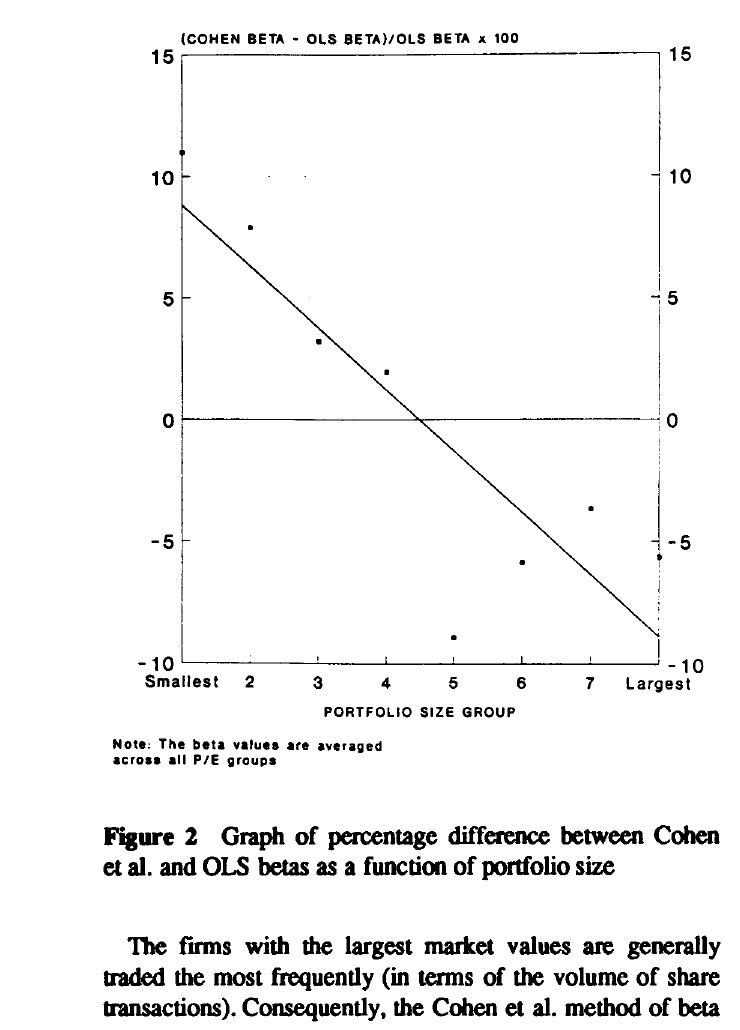
bias due to serial correlation.